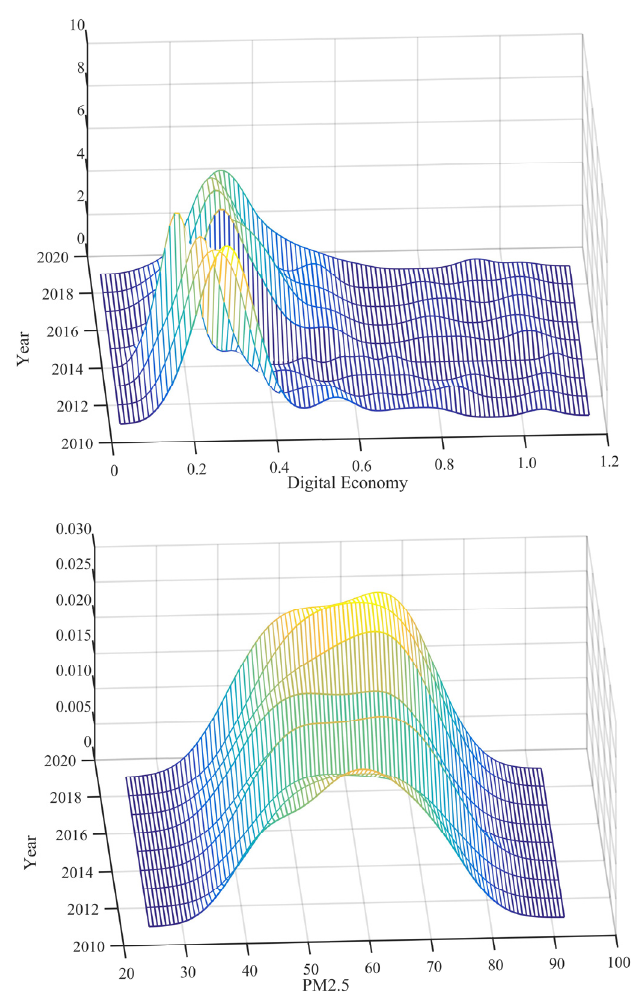
Figure 2. Kernel density estimation of the digital economy level and PM 2.5 concentration.